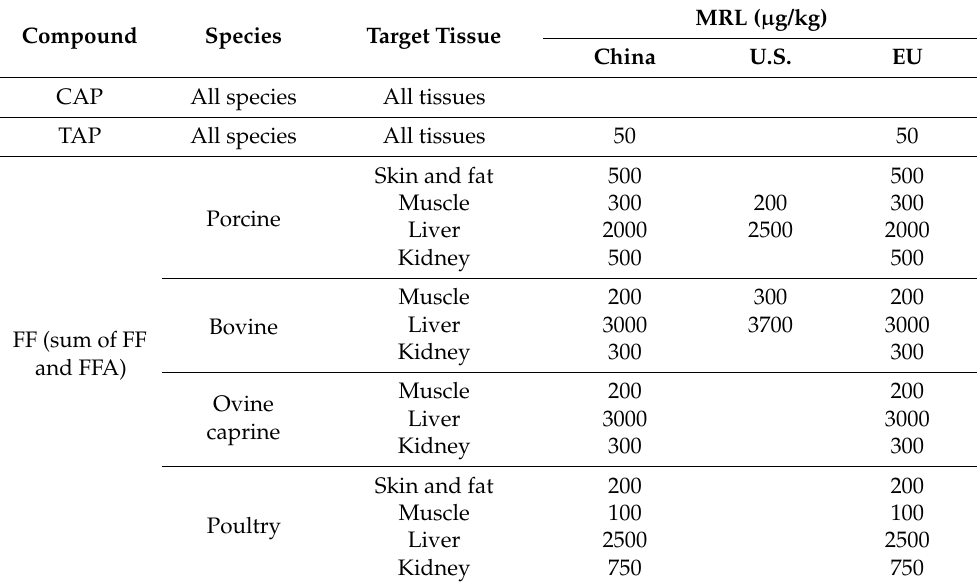
MRL ( µ g/kg) China U.S. EU